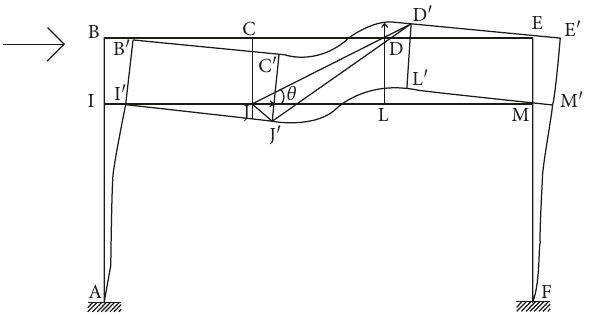
Figure 9: The undeformed and the deformed shape of the STMF configuration.